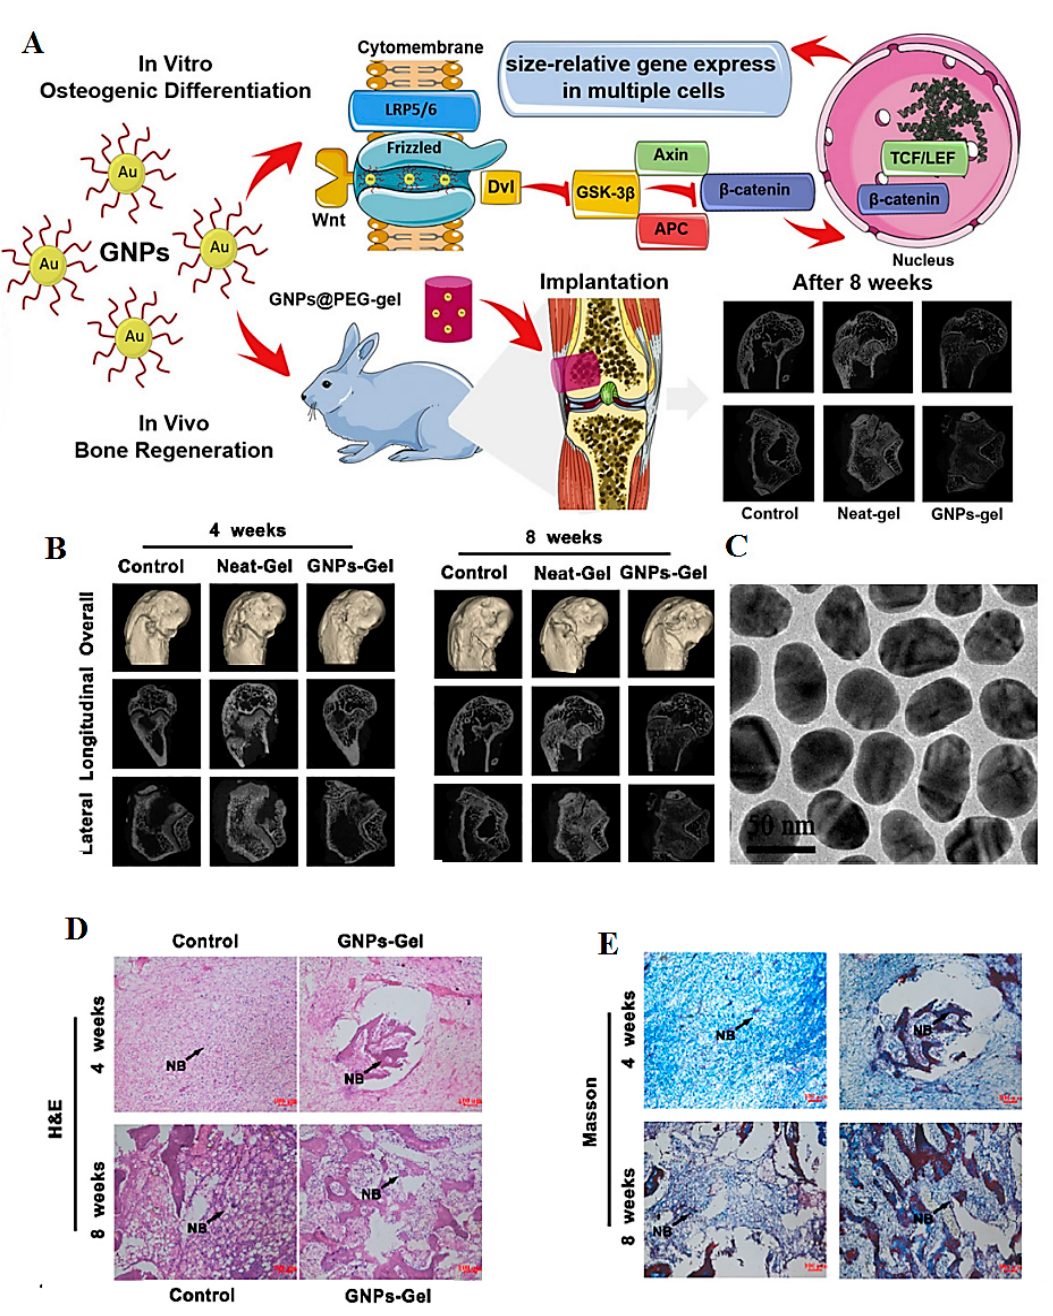
Figure 5. ( A ) Schematic illustration of the role of PEGylated Au NPs in improving osteogenic differentiation. ( B ) Three-dimensional (3D) micro-computed tomography (CT) images of femoral condyle at 4 and 8 weeks after being treated with neat-gel and Au NPs-gel, respectively. ( C ) Transmission electron microscopy (TEM) images of PEGylated Au NPs with a size of 45 nm. ( D , E ) Staining images of a bone defect implanted with PEG-gel and Au NPs-45 nm@PEG-gel on weeks 4 and 8, respectively. Au NPs: GNPs. Adapted from Ref [82] with permission. Copyright 2020 Elsevier.